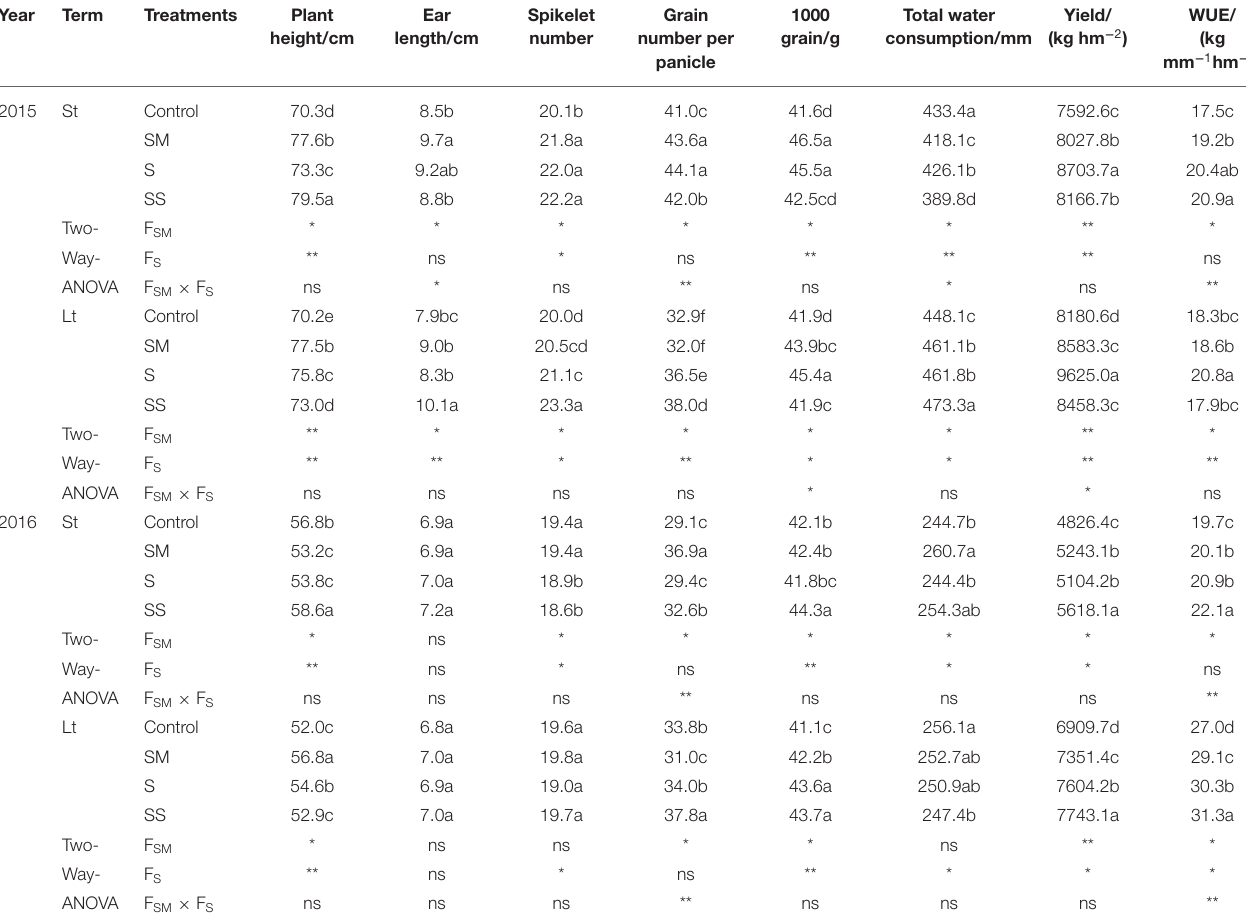
TABLE 4 | Yield, water use efficiency and yield component of wheat under the Control, SM, S and SS treatments in different